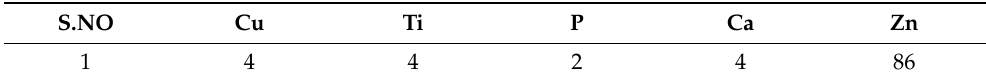
Table 1. Chemical composition in weight